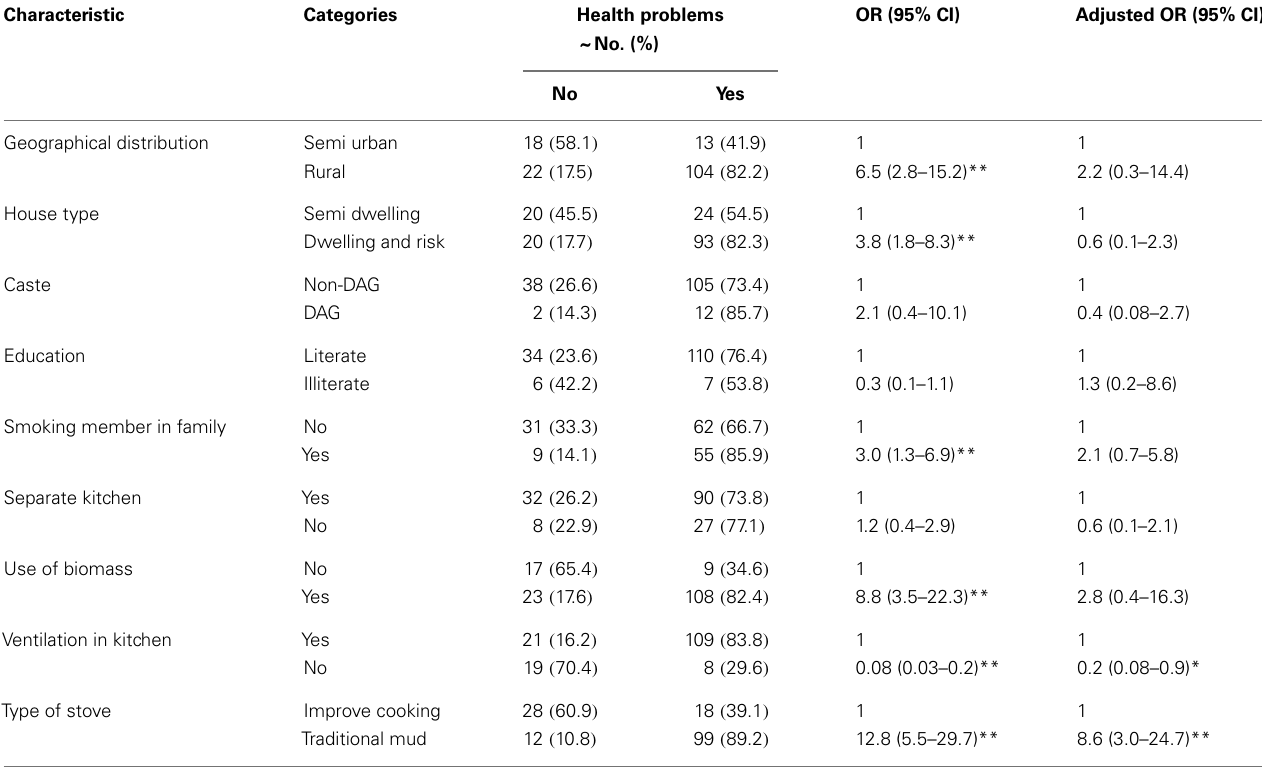
Table 5 | Comparison of risk by odds ratio associated health problems on logistic regression .